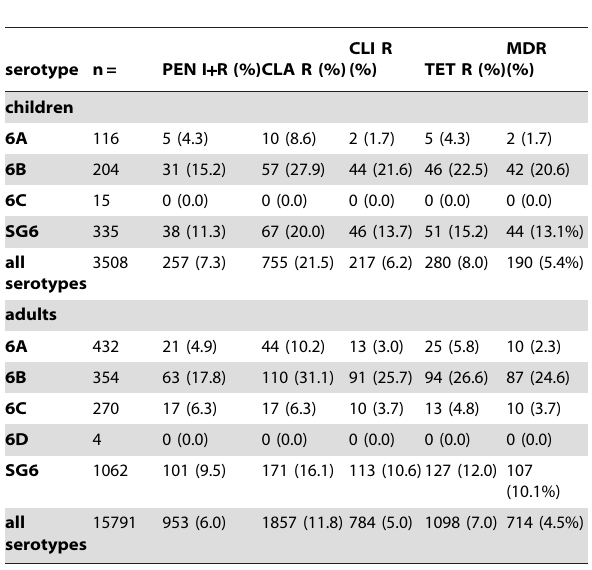
Table 2. Antibiotic resistance levels of serogroup 6 isolates from IPD among German children and adults.